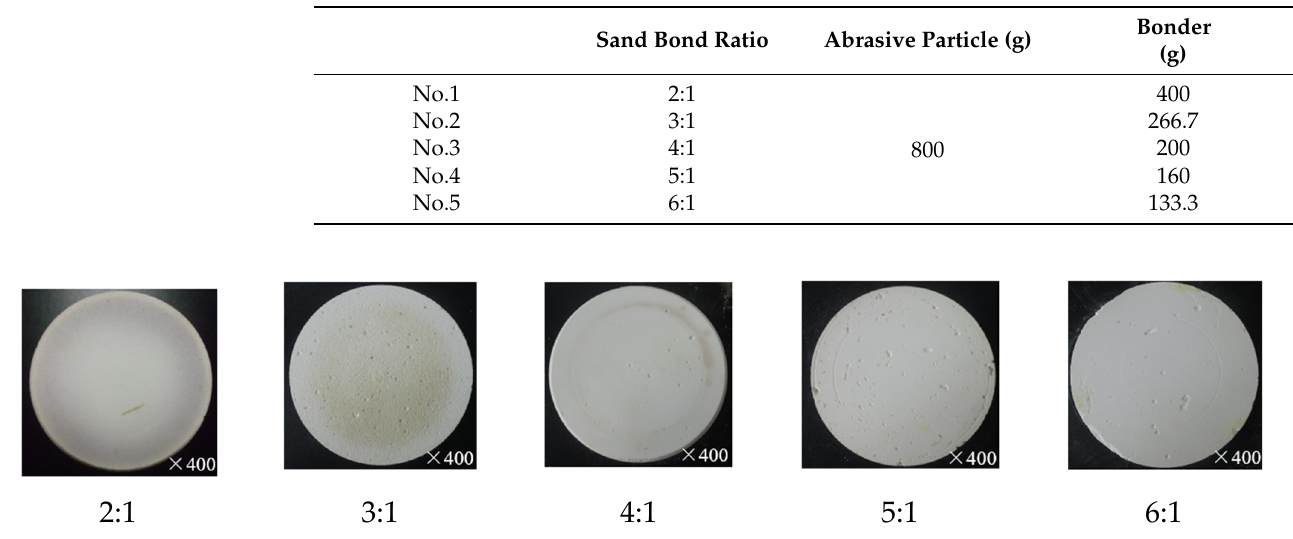
Figure 10. Optic pictures of polishing tool with 200 nm in abrasive particle size.